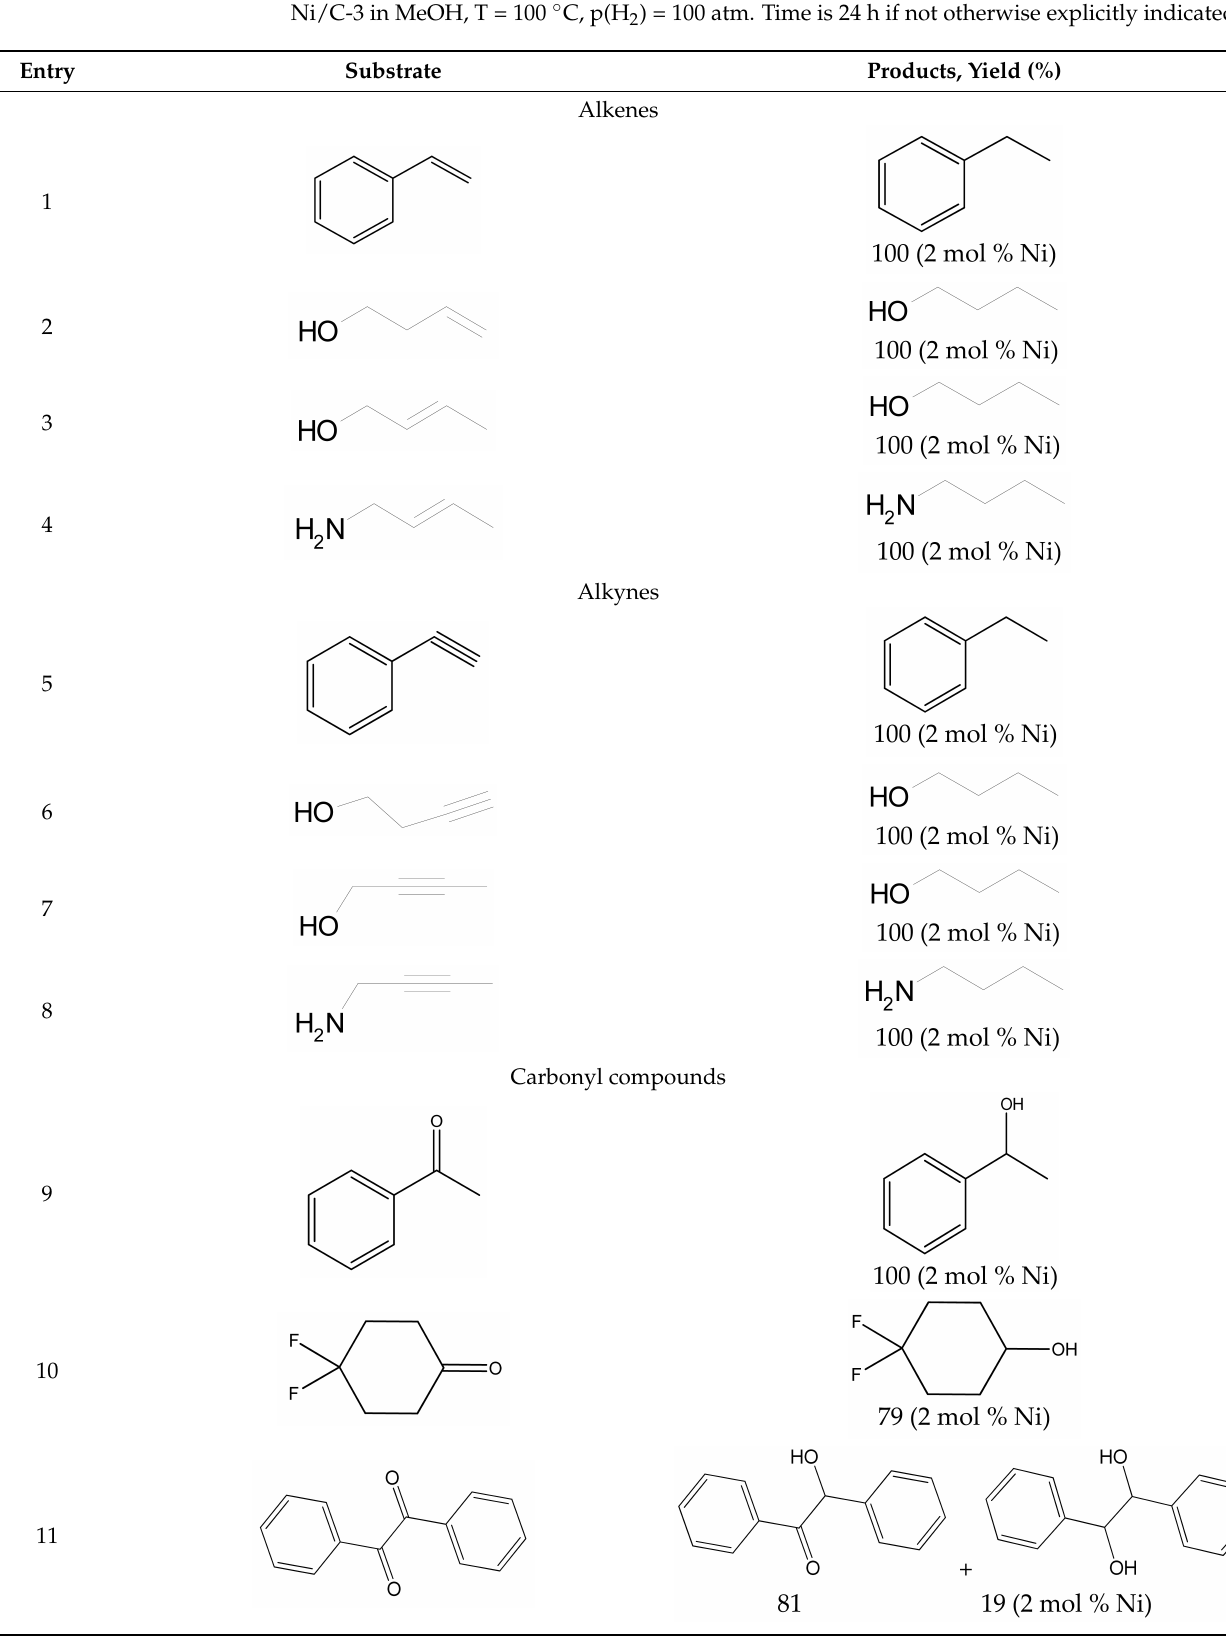
Table 4. Product yields in the processes of organic compound hydrogenation in the presence